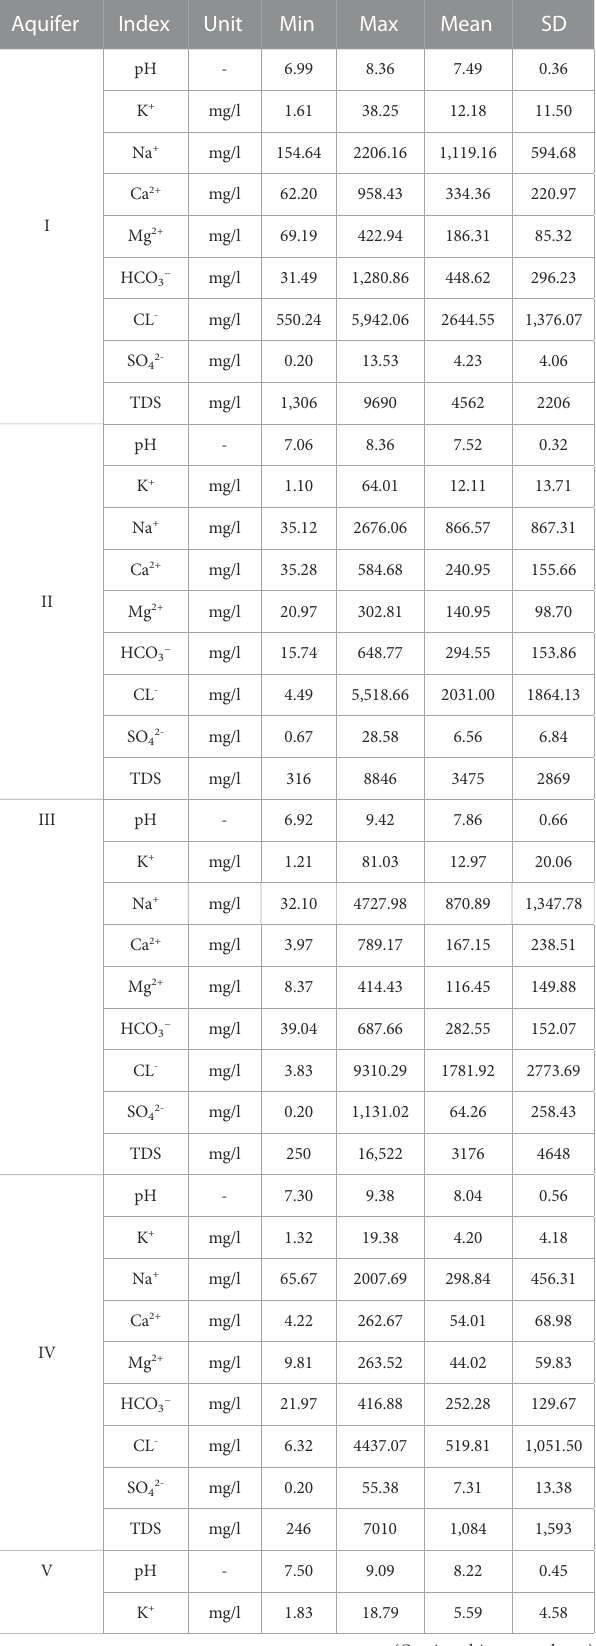
TABLE 2 Analysis results for con fi ned groundwater samples.